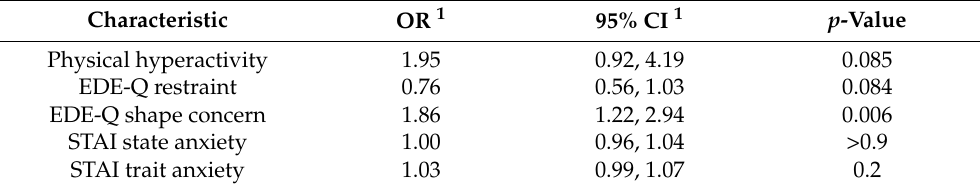
Table 3. Results from the logistic regression assessing inclusion in pre- and post-pandemic group. Characteristic OR 1 95% CI 1 p -Value Physical hyperactivity 1.95 EDE-Q restraint